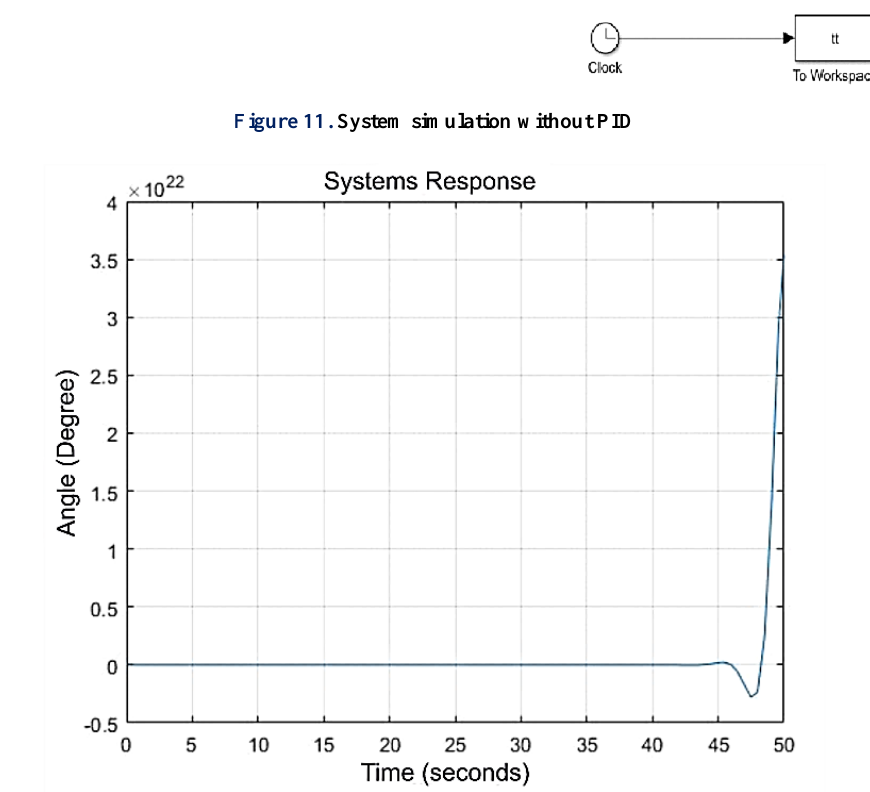
Figure 12. System simulation results in PID